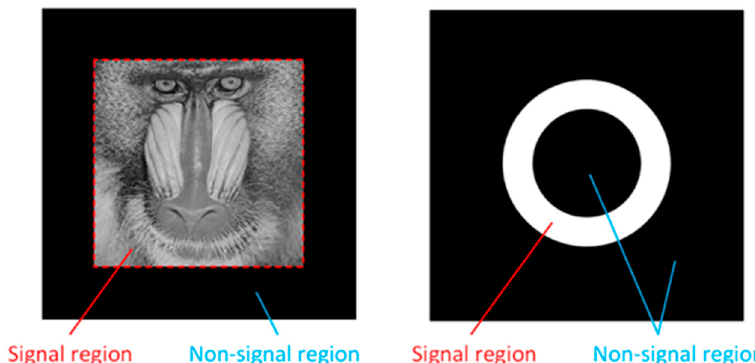
Figure 2. The partition strategy of the weighted constraint iterative algorithm (WCIA): The signal region is the area where the signal pattern is located, and the non-signal region is the area where there is no designed signal.